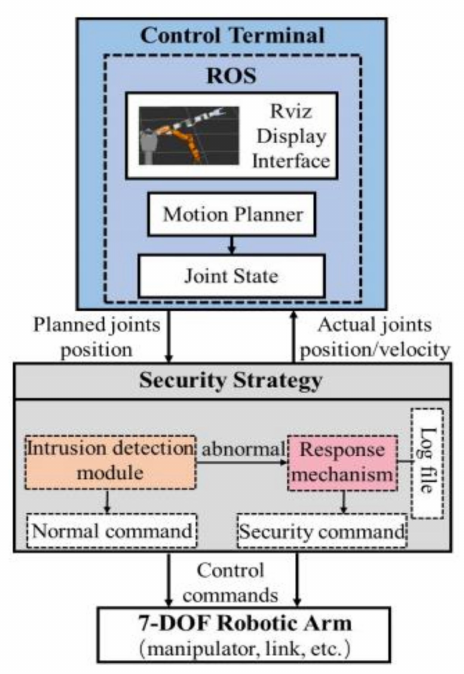
Figure 3. Robotic arm system based on detection and